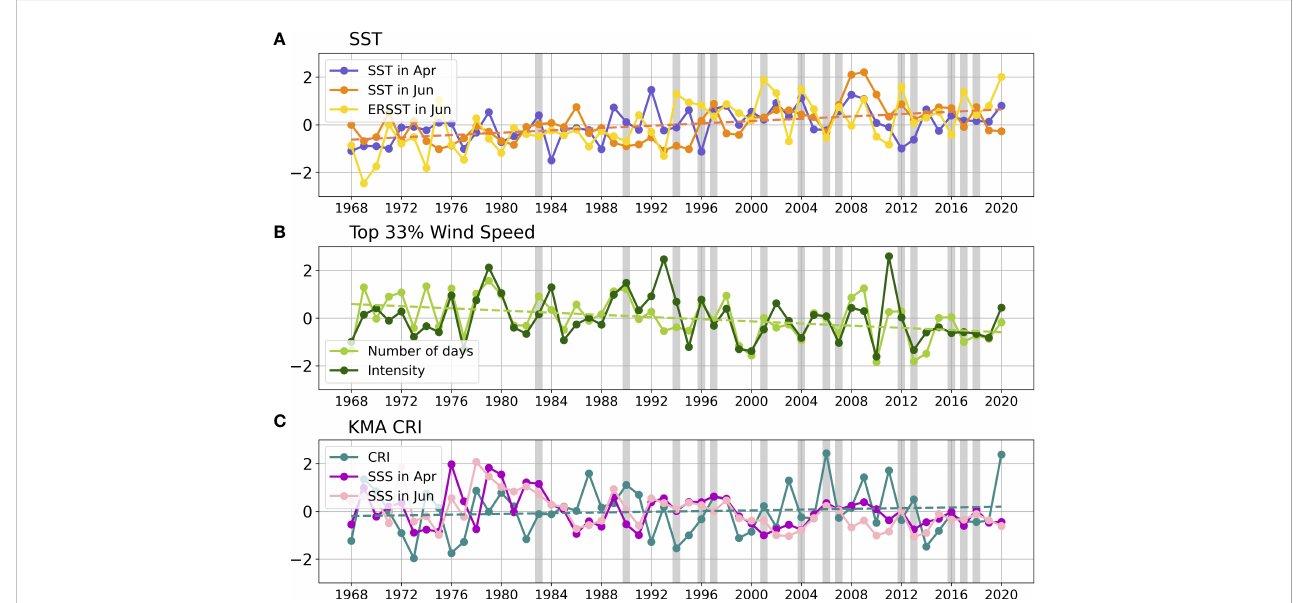
FIGURE 2 (A) Standardized SST anomaly in June from NIFS station data in orange, from ERSSTv4 in yellow, (B) same as (A) except for occurrence exceeding top 33% percent daily wind speed (mint) and average speed of top 33% percent daily wind speed (green), (C) same as (A) , but for surface salinity (pink) and KMA Changma Index (bluegreen), area-averaged in the boxed area de fi ned in Figure 1A, except for KMI Changma